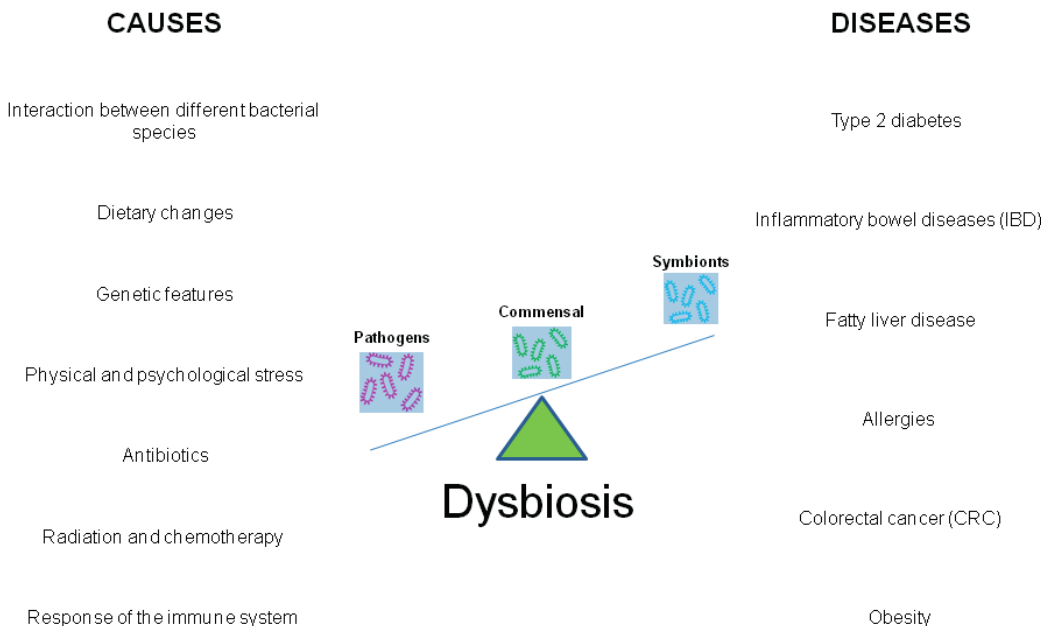
Fig. 2. Causes of dysbiosis and related diseases. Dysbiosis is a state of imbalance between the various organisms inhabiting the human gut. It can be caused by hereditary factors, some drugs such as antibiotics, radiotherapy and chemotherapy, age, but is mostly related to poor nutrition and physical and psychological stress which results in a dysregulation of the immune system. All of these predispose to the onset of conditions as type 2 diabetes, liver disease and especially inflammatory bowel disease (IBD) and colorectal cancer